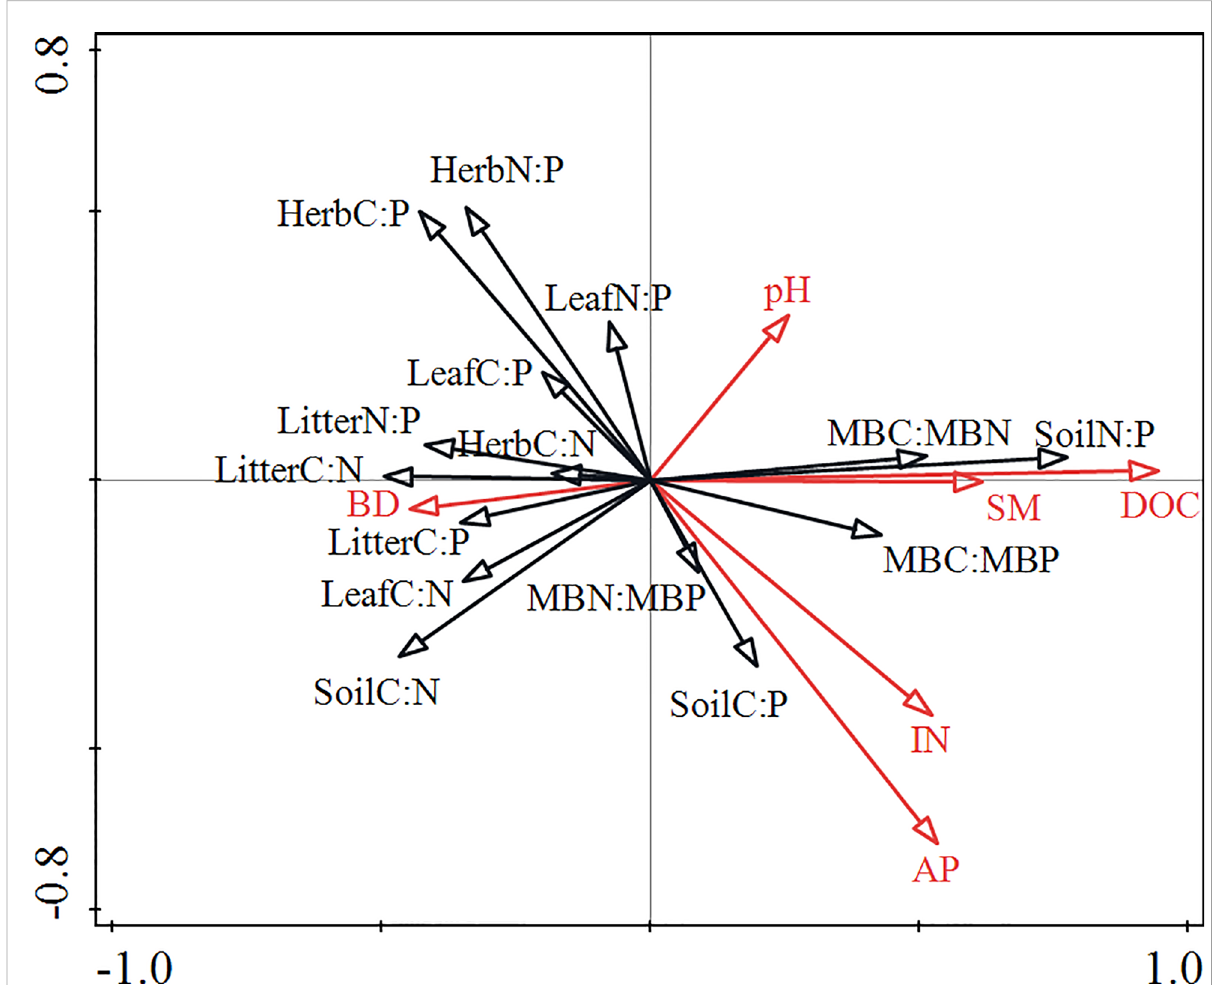
FIGURE 3 Redundancy analysis (RDA) showing the relationship between the plant-soil-microbe C:N:P ecological stoichiometry and soil physicochemical properties. SM, soil moisture content; IN, inorganic N (NH4+-N and NO3¯-N); AP, available phosphorus; BD, soil bulk density; DOC, dissolved organic carbon; Herb, understorey herb